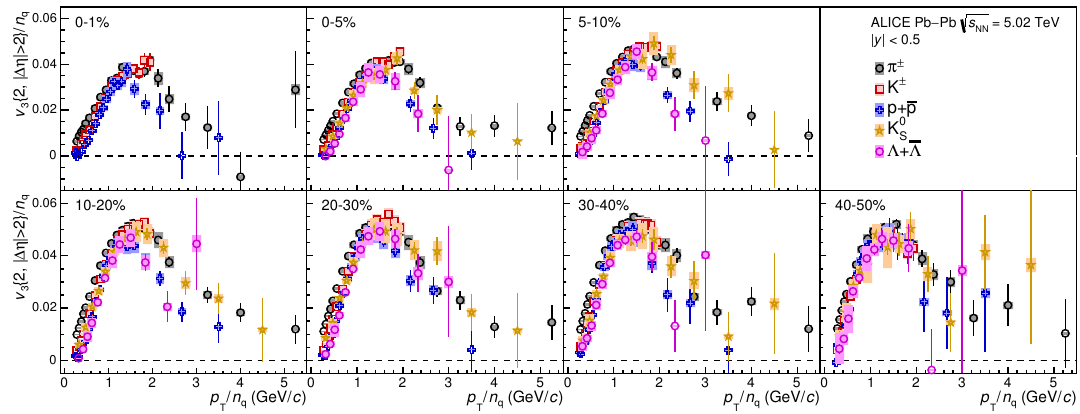
Figure 10 . (Colour online) The p T =n q dependence of v 3 =n q of (cid:25) (cid:6) , K (cid:6) , p+p, (cid:3)+(cid:3), and K 0 various centrality classes. Statistical and systematic uncertainties are shown as bars and boxes, respectively.